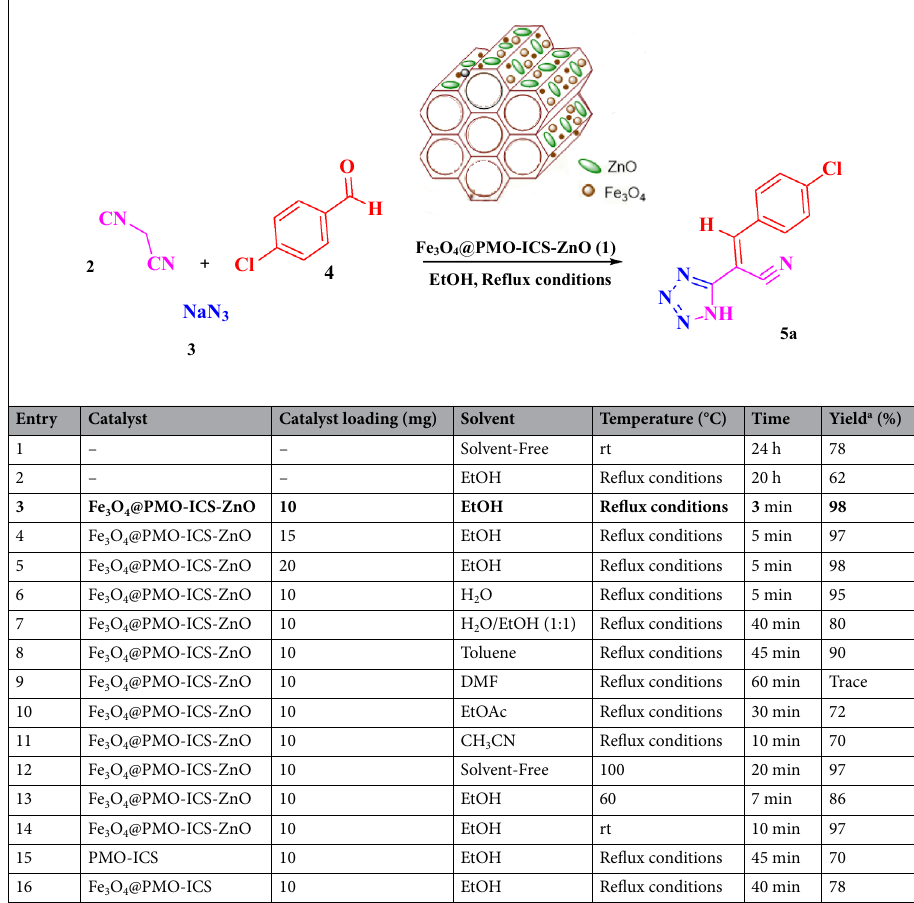
Table 2. Optimization of conditions in the reaction of malononitrile ( 2 ), NaN 3 ( 3 ) and 4-chlorobenzaldehyde ( 4a ) under different conditions. Reaction conditions: malononitrile ( 2 , 1 mmol), NaN 3 ( 3 , 1.2 mmol) and 4-chlorobenzaldehyde ( 4a , 1 mmol) were added into the solvent (2.0 mL) in the presence of Fe 3 O 4 @ PMO- ICS-ZnO ( 1 ) unless otherwise stated. a Isolated yields. Significant values are in